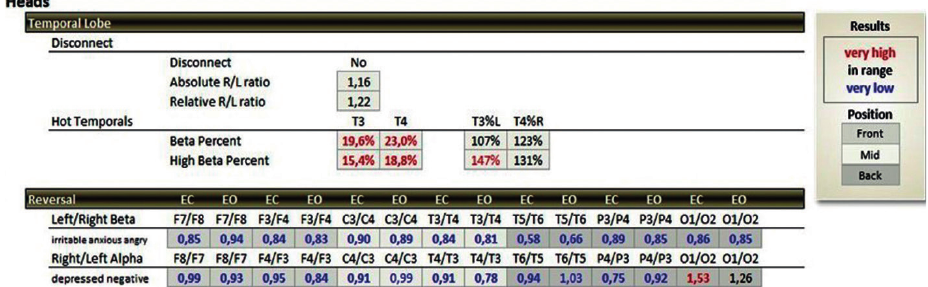
Figure 3. Percentage quantity above the expected beta wave (15-23 Hz >17%) and Beta-High (23-38 Hz >10%) at the T3 and T4 points of the 10-20 electroencephalography system in a summary statistical distribution (TQ-7 analyze page), expressed in red color, representing the group studied (hot temporal lobes).